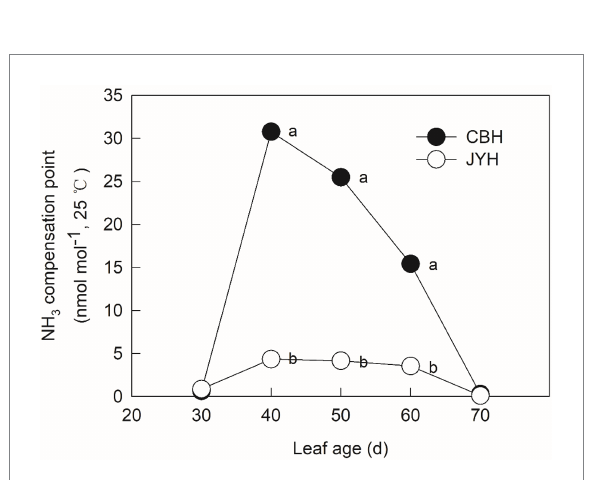
FIGURE 2 NH 3 compensation point in resistant and susceptible tobacco cultivars to Alternaria alternata . Values with different letters are significantly different ( p ≤